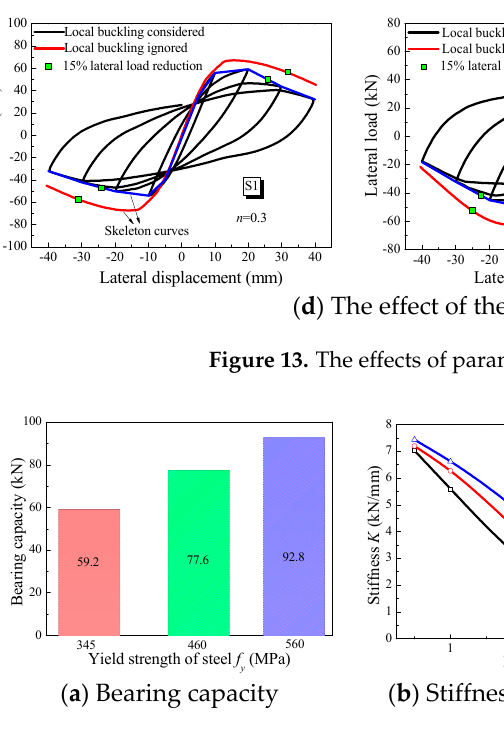
Figure 14. The e ff ect of the yield strength of steel.